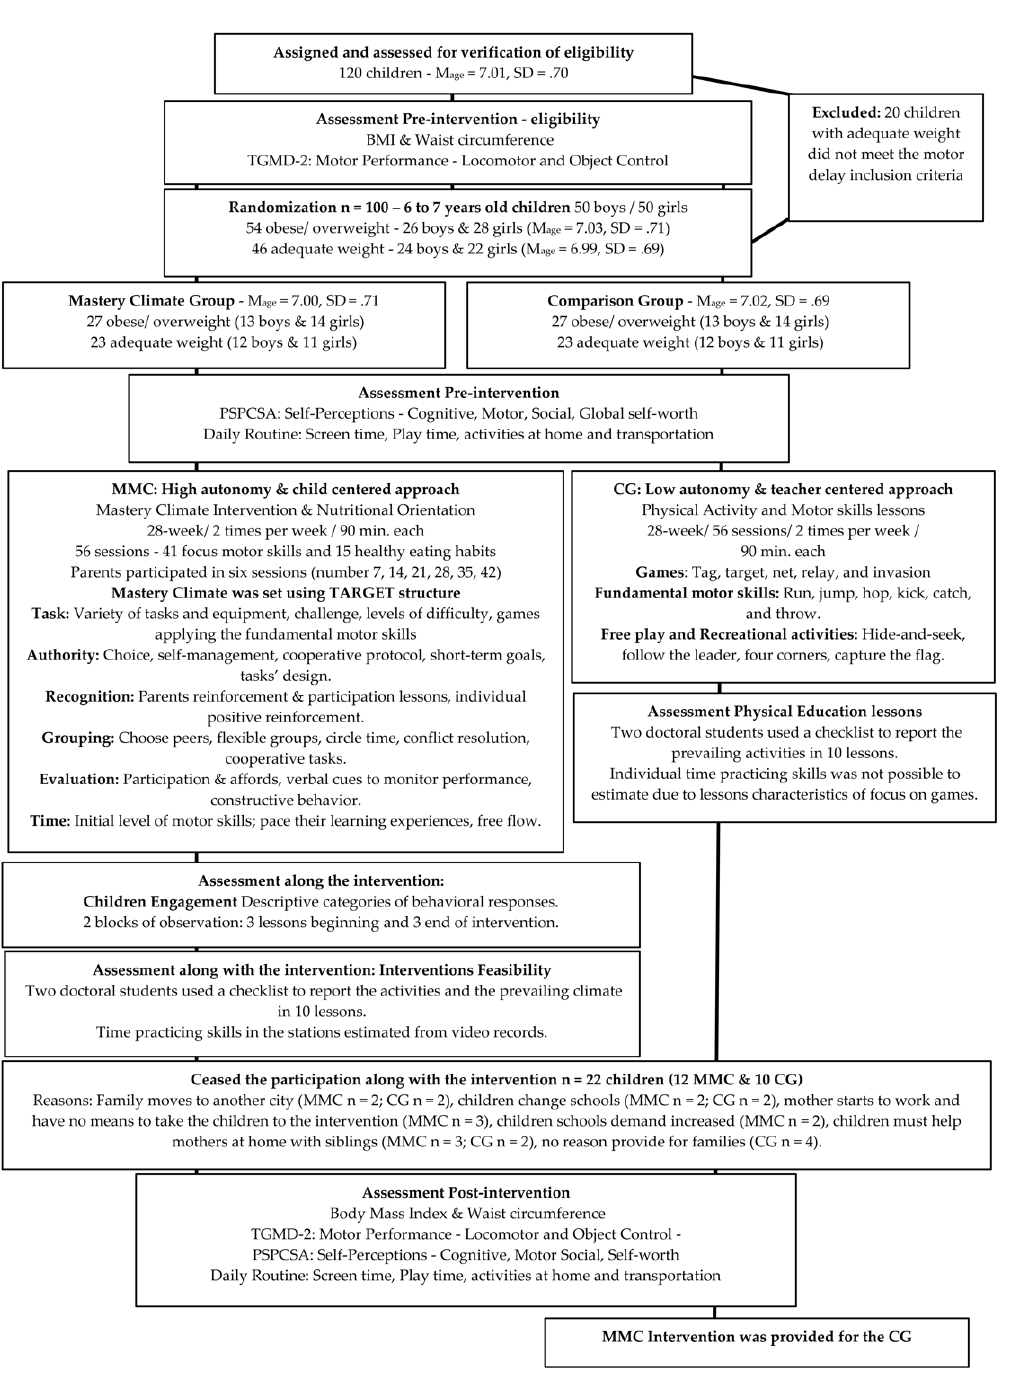
Figure 1. Research Design: Groups, assessments, and intervention.